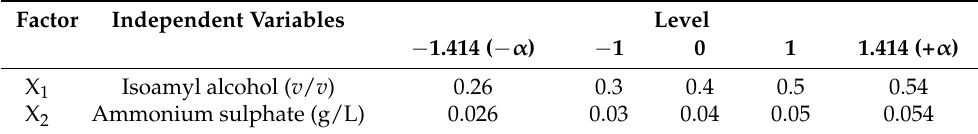
Table 1. Levels of the factors used in the optimization of the maximum production rate of isopentyl acetate.